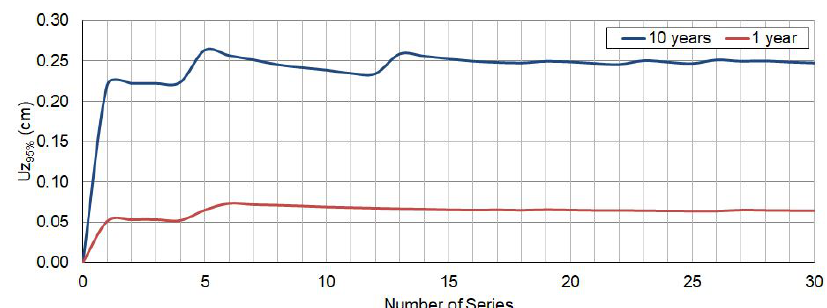
Figure 14. Convergence of the characteristic displacements values considering a period of recurrence equal to 10 years and 1 year. Table 3 D ynamic structural response of the investigated building: maximum displacements and peak accelerations values. Time of recurrence: 10 Nondeterministic Loading Series